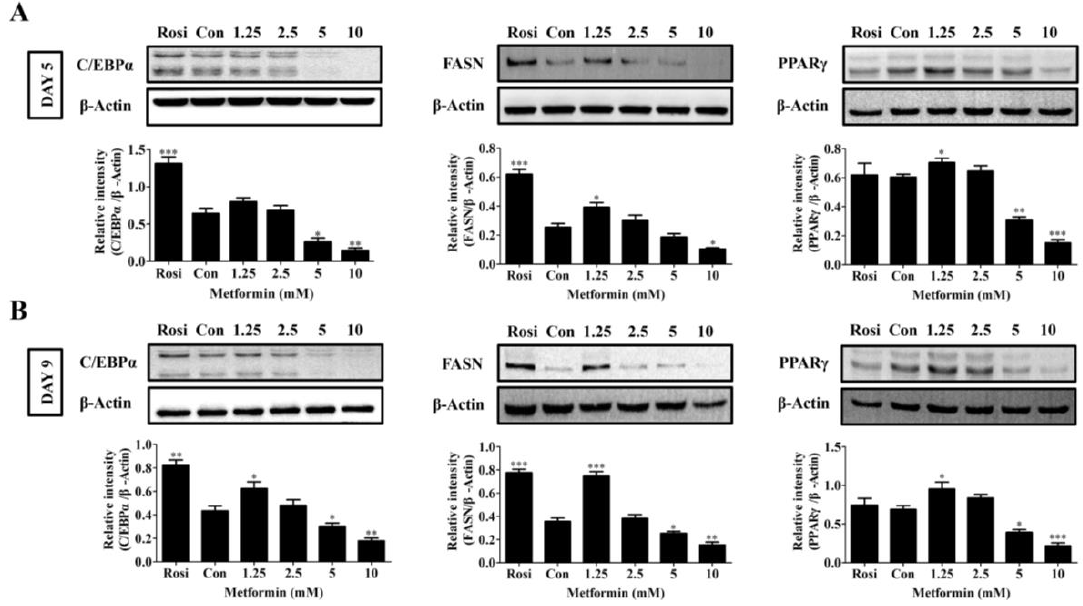
Figure 4. Effects of different doses of metformin (1.25 – 10 mM) on the expression of adipogenesis markers FASN, PPAR γ , and C/EBP α in 3T3-L1 cells. ( A ) Expression levels at day 5 (DAY 5) after differentiation initiation as determined by Western blot analysis ( n = 3); ( B ) Expression levels at day 9 (DAY 9) ( n = 3). Rosiglitazone (Rosi, 2.5 µ M) was used as a positive control. Results were quantified using densitometry analysis and normalized to β -Actin. The data represent the means ± SEM from three independent experiments. * p < 0.05, ** p < 0.01, and *** p < 0.001 as compared with DMI alone treated cells (one-way ANOVA with Dunnett’s correction).